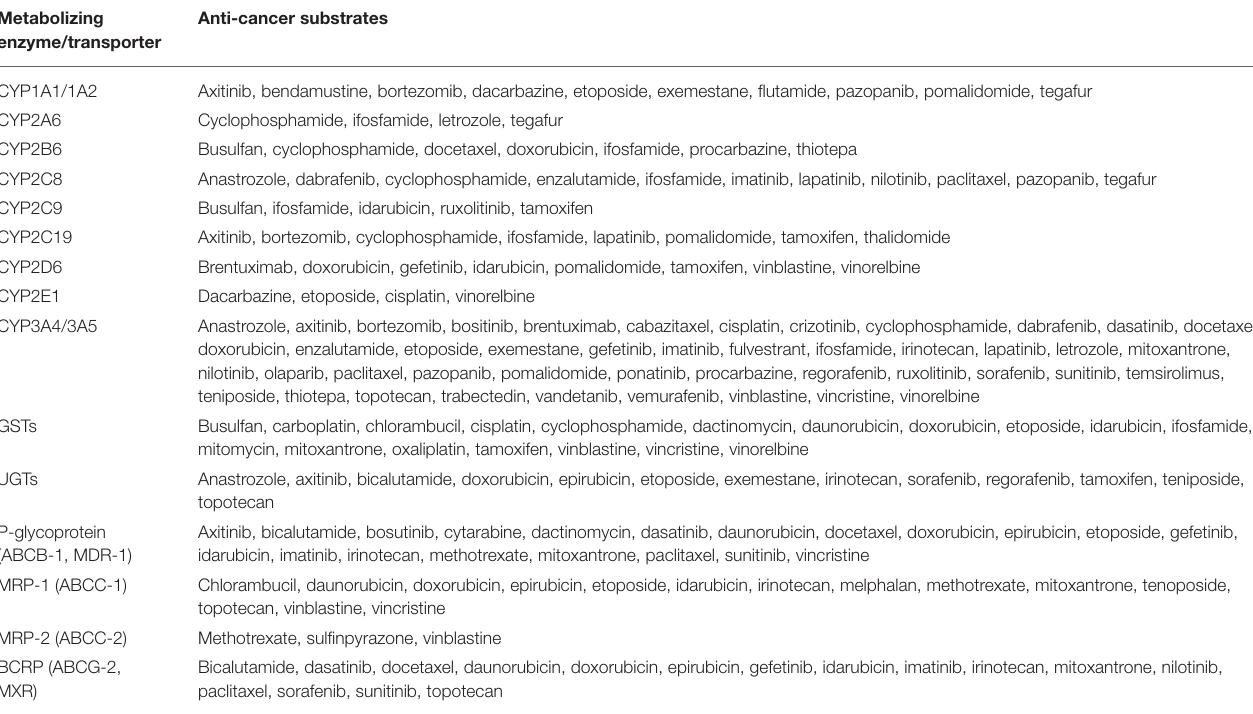
TABLE 2 | Several anti-cancer drugs are substrates of drug-metabolizing enzymes and transport proteins. Metabolizing